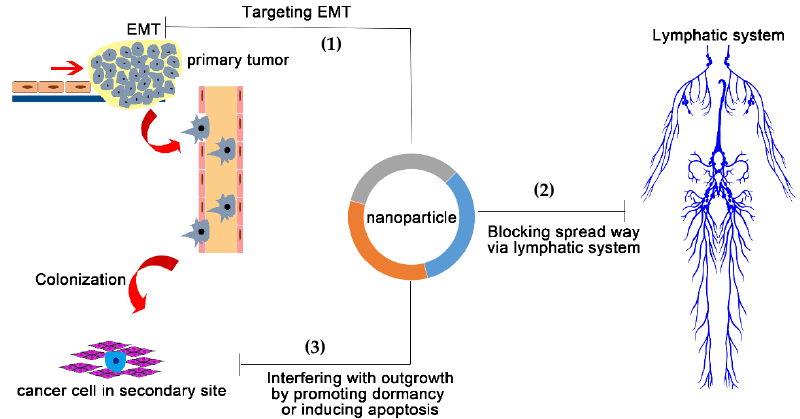
Figure 3. Three potent strategies to stop MBC metastasis via nanotechnology. (1) Reversing Epithelial Mesenchymal Transition (EMT) to reduce the mobility of MBC cells in the primary tumor